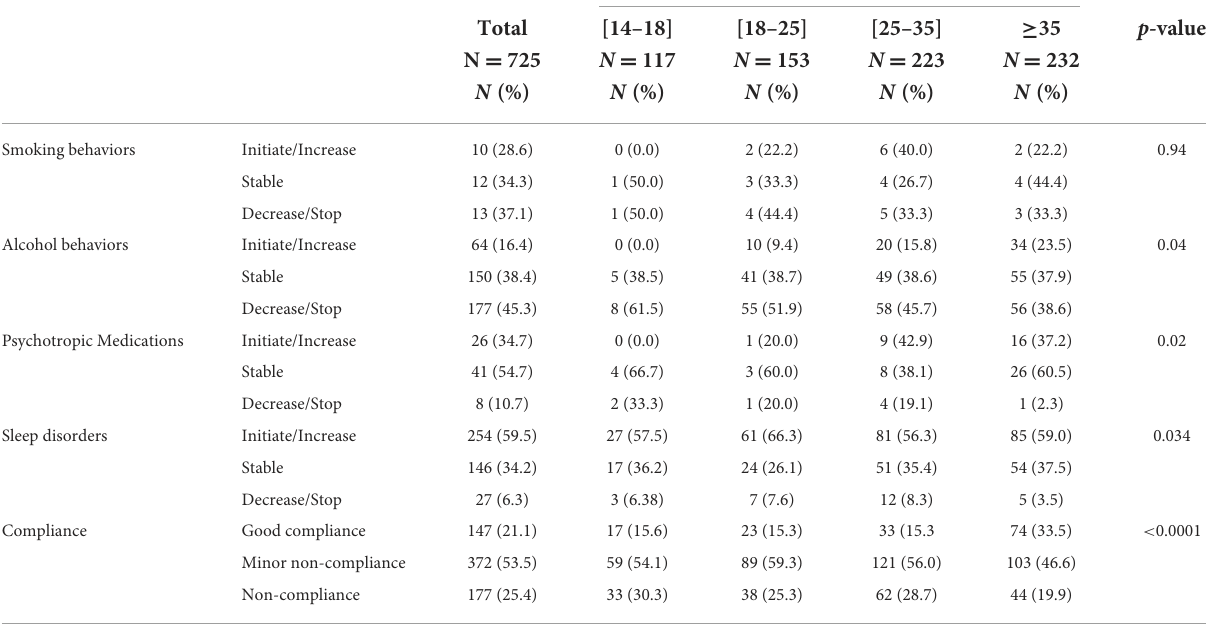
TABLE 5 Impact of COVID-19 pandemic and associated lockdown measures on treatment, alcohol, and smoking